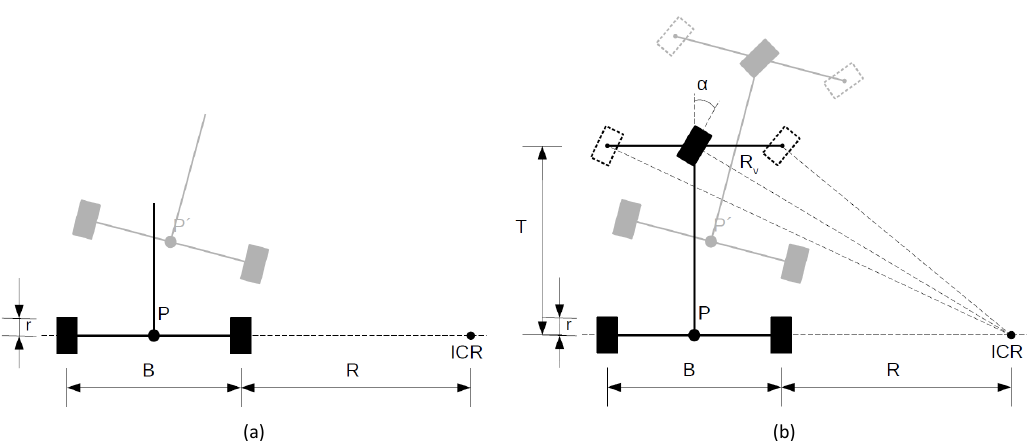
Figure 4. Visualization of the kinematic models used for the performed mobile robot ( a ) and car experiments ( b ). For both models, we assumed a rigid frame. For the car model, we used a simplified version of Ackermann steering using a virtual wheel. The doted lines are the zero-motion lines of the wheels and thus represent kinematic constrains of the